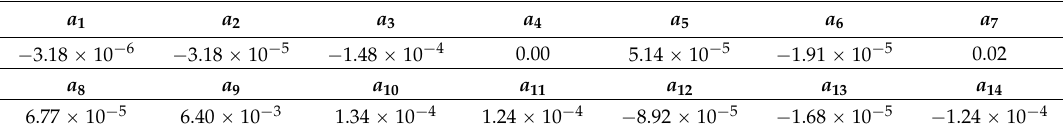
Table 1. Parameters of the freeform surfaces.